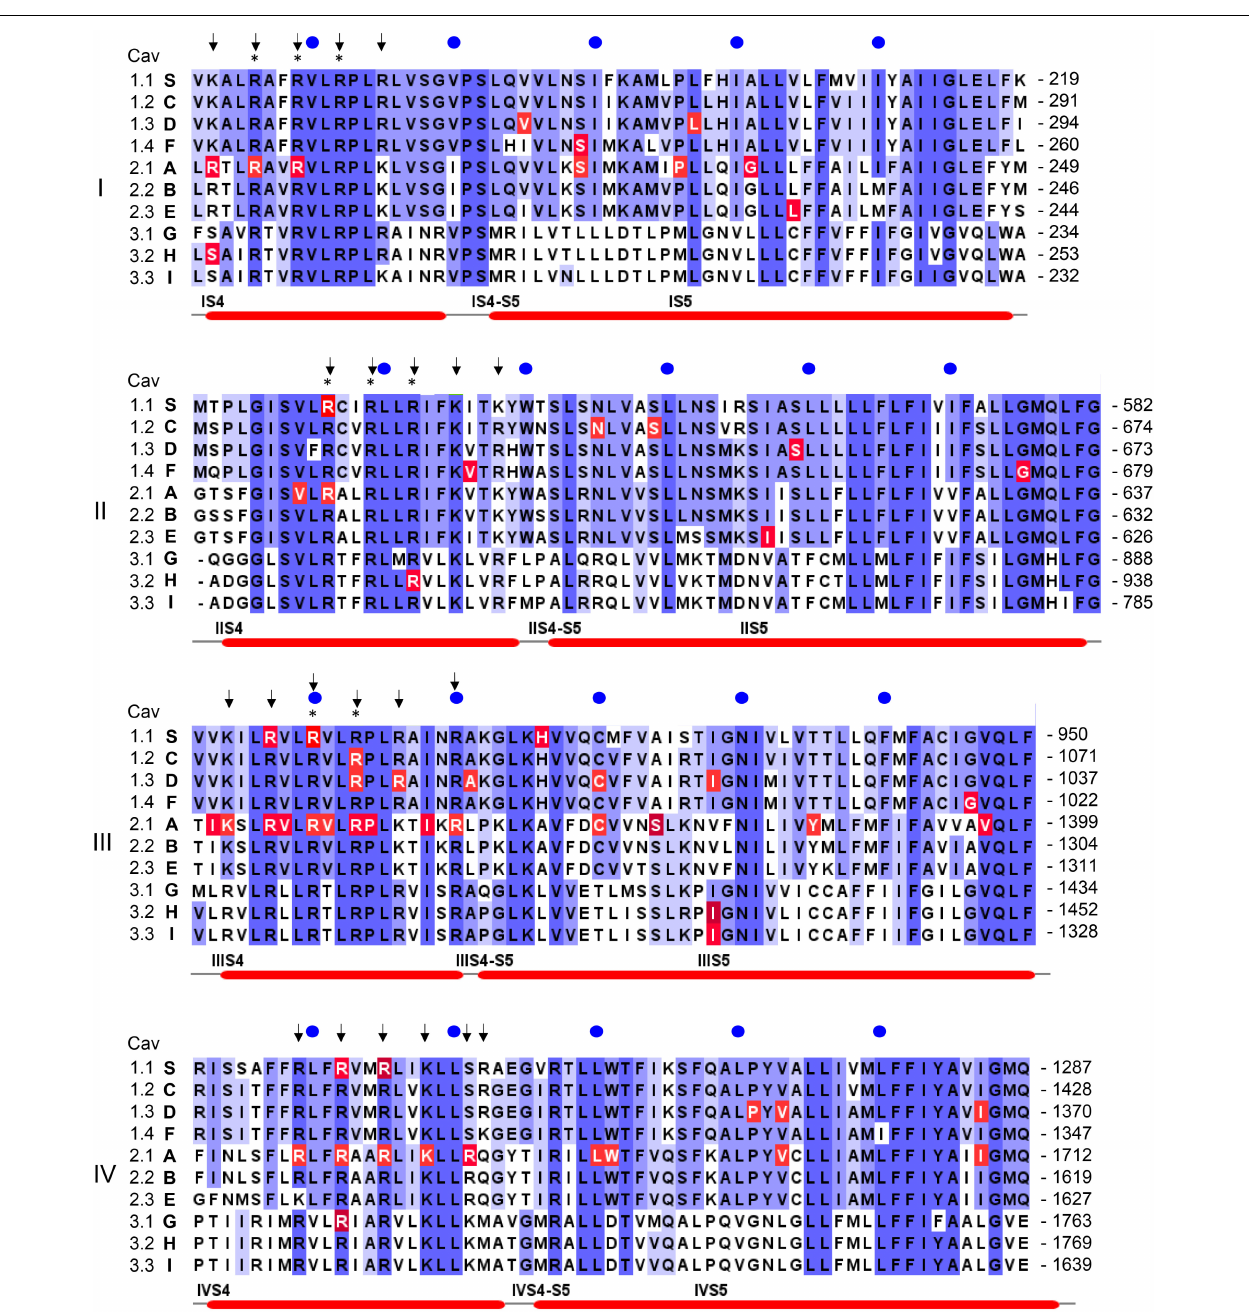
FIGURE 4 | Position of pathogenic mutations within S4, the S4-S5 linkers and S5 helices of the ten different Ca 2 + channel α 1-subunits. The sequence alignment for the human α 1-subunits was generated using Clustal omega and Jalview software (www.jalview.org; Waterhouse et al., 2009). Conserved residues are highlighted in blue. The accession numbers are identical to the alignment in Wu et al. (2016): CACNA1S (S, Cav1.1): Q13698; CACNA1C [C, Cav1.2; contains exon 8a (Splawski et al., 2005)]: Q13936; CACNA1D (D, Cav1.3): Q01668; CACNA1F (F, hCav1.4): O60840; CACNA1A (A, Cav2.1): O00555; CACNA1B (B, Cav2.2): Q00975; CACNA1E (E, hCav2.3): Q15878; CACNA1G (G, hCav3.1): O43497; CACNA1H (H, hCav3.2): O95180; CACNA1I (I, hCav3.3: Q9P0 × 4. All amino acid positions in the text are numbered according to the above Uniprot accession numbers and may differ in the original publications or other databases. Arrows indicate the position of positively charged residues (gating charges) in S4 helices, asterisks indicate the presence of pathogenic gating pore mutations in human Nav1.4 ( SCNA4 ) or Nav1.5 ( SCNA5 ) Na + -channels. Numbers on the right indicate the amino acid position of the last residue in each line, blue circles are 10 residues apart. Red lines on the bottom denote secondary structural elements of the rabbit Cav1.1 channel (Wu et al., 2016) with labels placed at the start of a feature. Residues affected by a mutation are highlighted in red. Note that not all highlighted mutations are discussed in the text. For information on mutations in all Ca 2 + channels refer to the Uniprot-database and to reviews cited in the